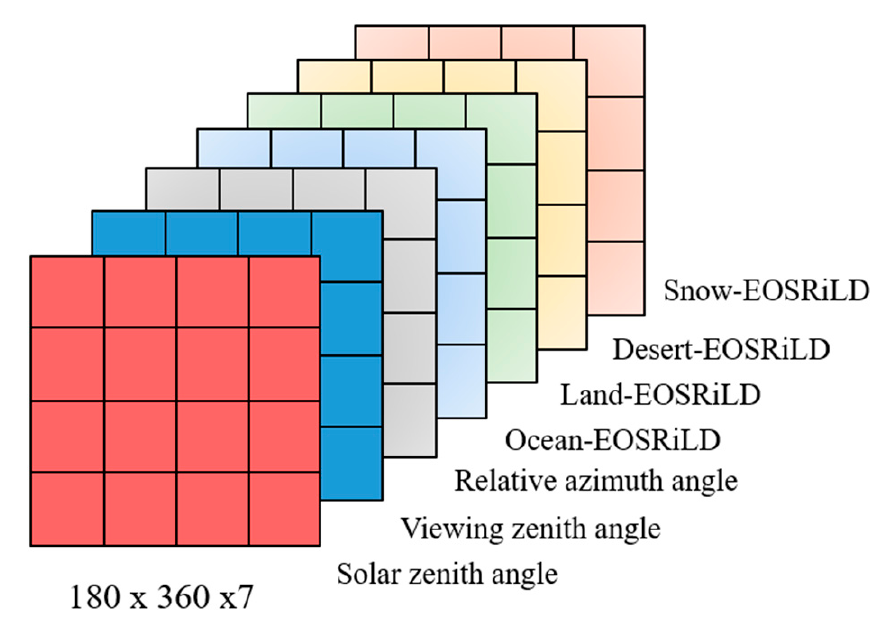
Figure 15. Schematic of sets of data at the same time.